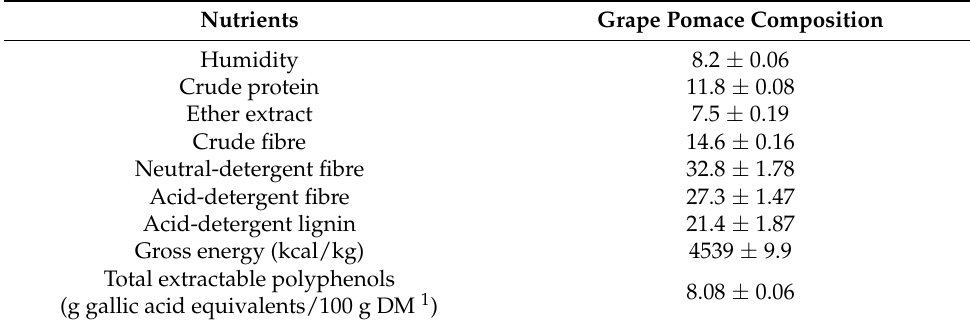
Table 1. Proximate composition (g/100 g) of grape